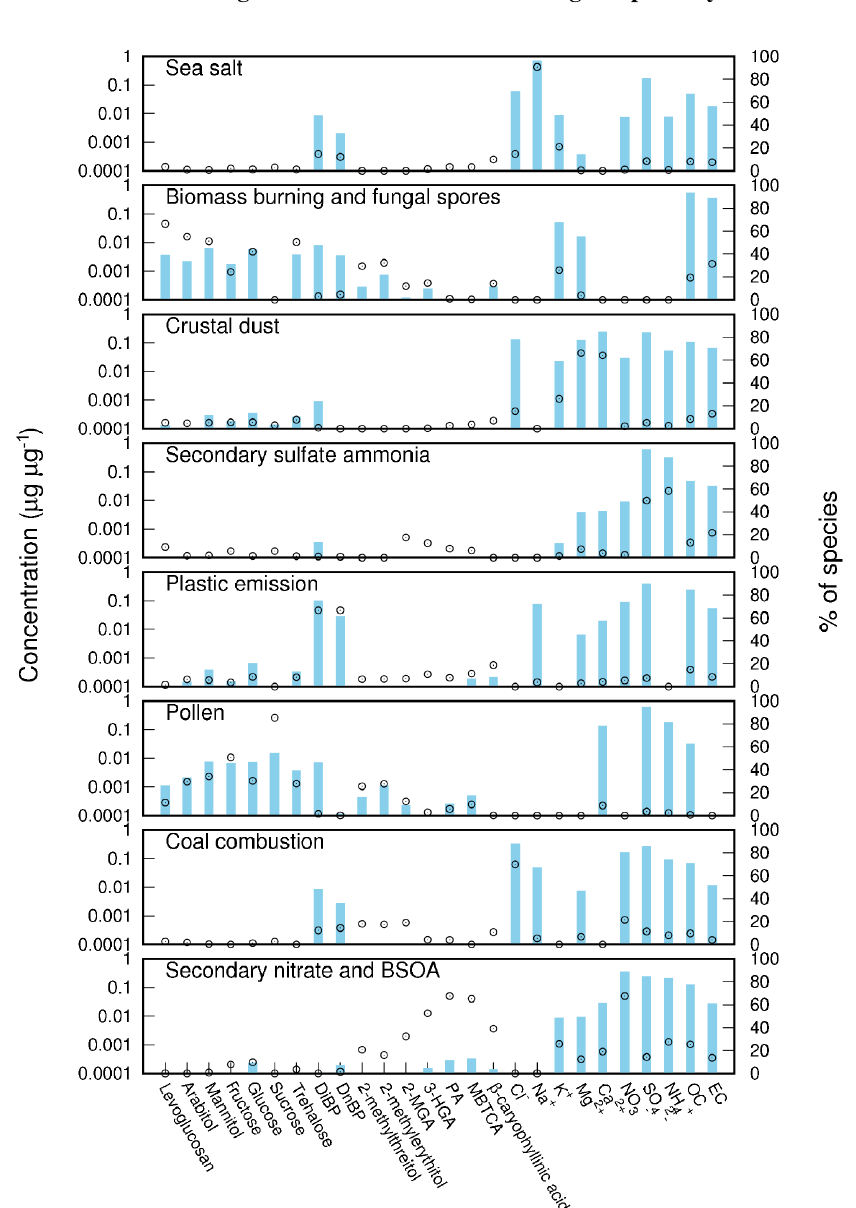
Figure 10. Source profiles identified by PMF. Blue bars represent the mass contribution with the y axis on the left, while black dots stand for the percentage of species to the sum shown by the y axis on the